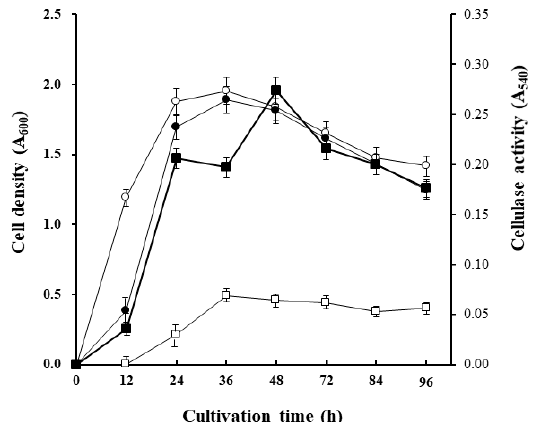
Figure 3. Cell growth and cellulase production by Cellulophaga sp. J9-3 in Marine Broth containing carboxymethylcellulose at different cultivation times. Cell density (A 600 ) in Marine Broth (MB, ○ ) and